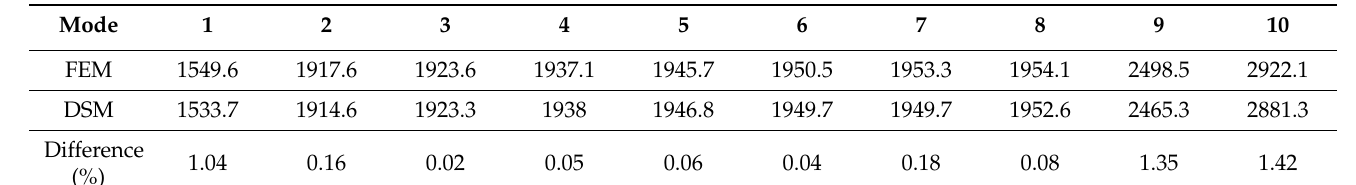
Table 5. Natural Frequencies, ω ( rad / s ) of Euler–Bernoulli Beam Analysis with Hinged ends in Topology 1, Original Configuration.